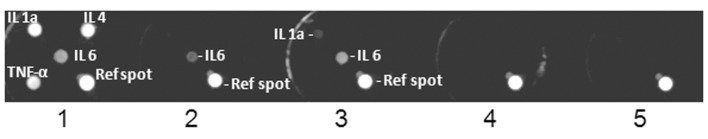
Cytokine array analysis. Induction of cytokine expression (IL-6 and IL-1α) by ACA. (1) Cytokine antigen standard; (2) U87 vehicle-treated control cells; (3) U87 cells treated with 2 μM ACA; (4) A172 vehicle-treated control cells; (5) A172 cells treated with 2μM ACA. Experiment shown is representative of 3 independent experiments performed in duplicate that displayed similar results. ACA, acetoxychavicol acetate.